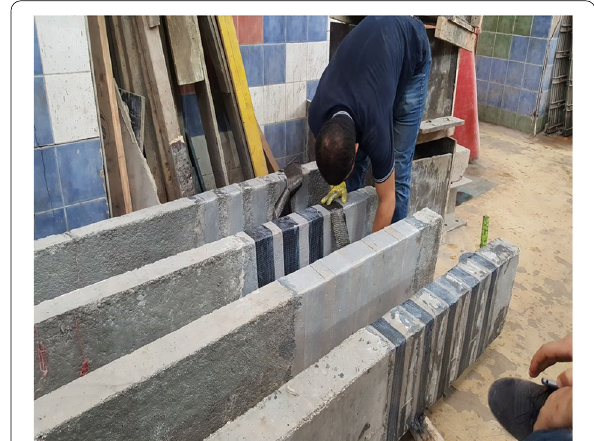
Fig. 5 U-shape FRP wrapping.